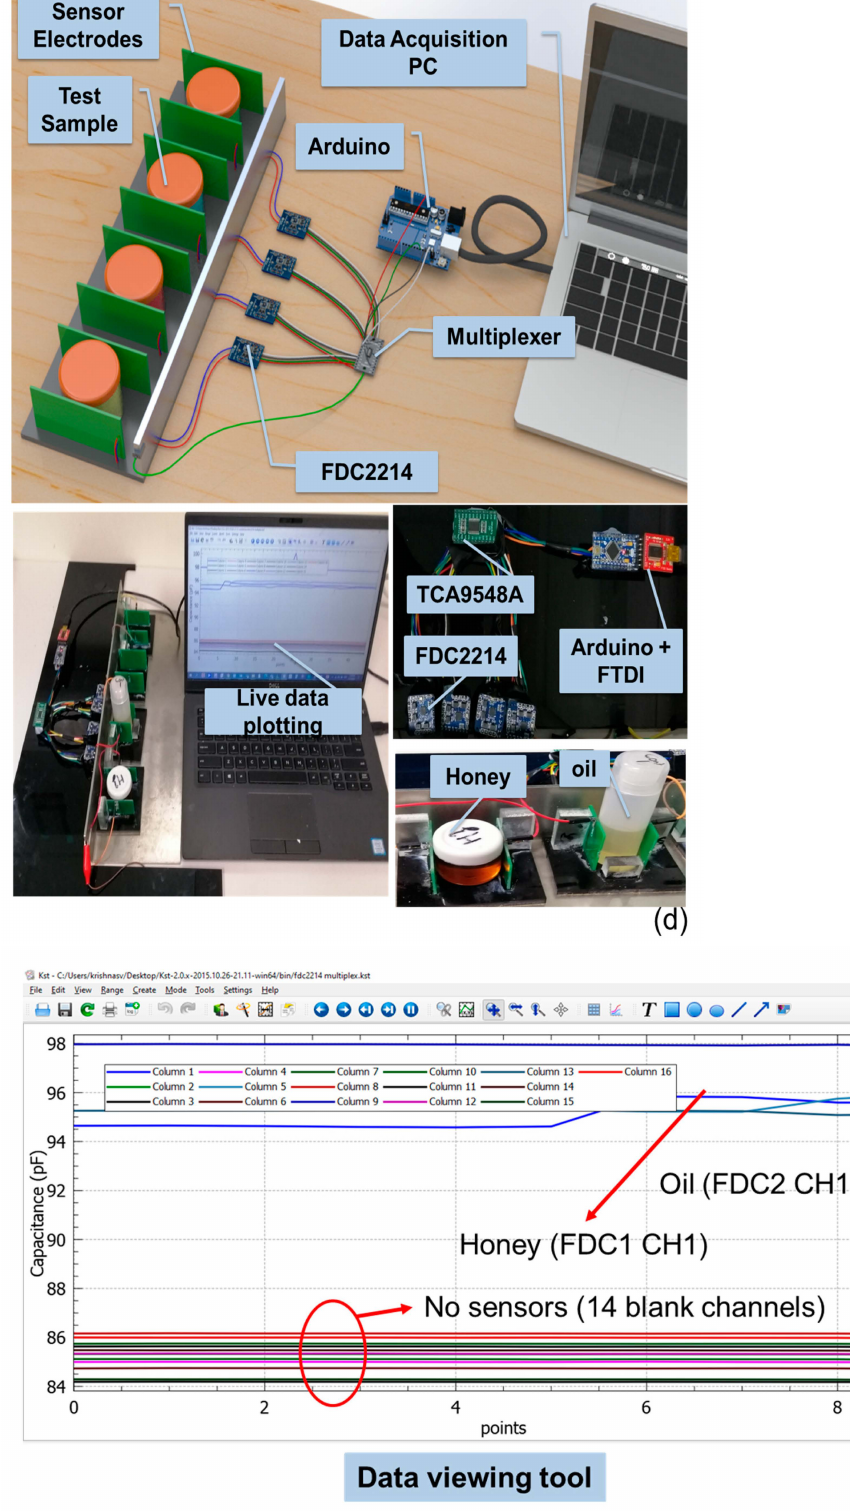
Figure 10. Automated low-cost capacitive EVOO adulteration detection system: ( a ) Arduino-based FDC2214 sensing set up with LED output showing EVOO (OFF) and adulterated EVOO (ON) detection through threshold setting. ( b ) Comparison of ∆ C EVOO /C EVOO ( ± σ ) of FDC2214EVM and Arduino-based EVOO adulteration testing system for adulterant oils and EVOO with